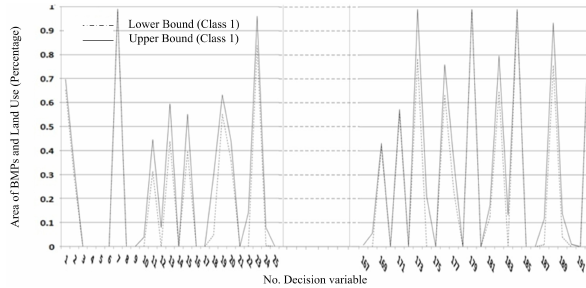
Fig. 8. Variation of decision variable in class 1 based on the k -means method.